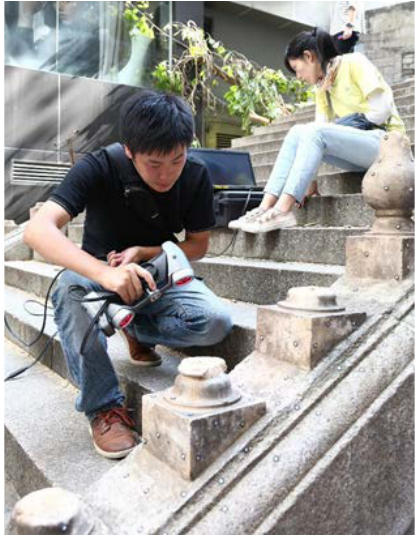
Figure 7: 3DSU using a portable 3D scanner to scan the surviving structures on